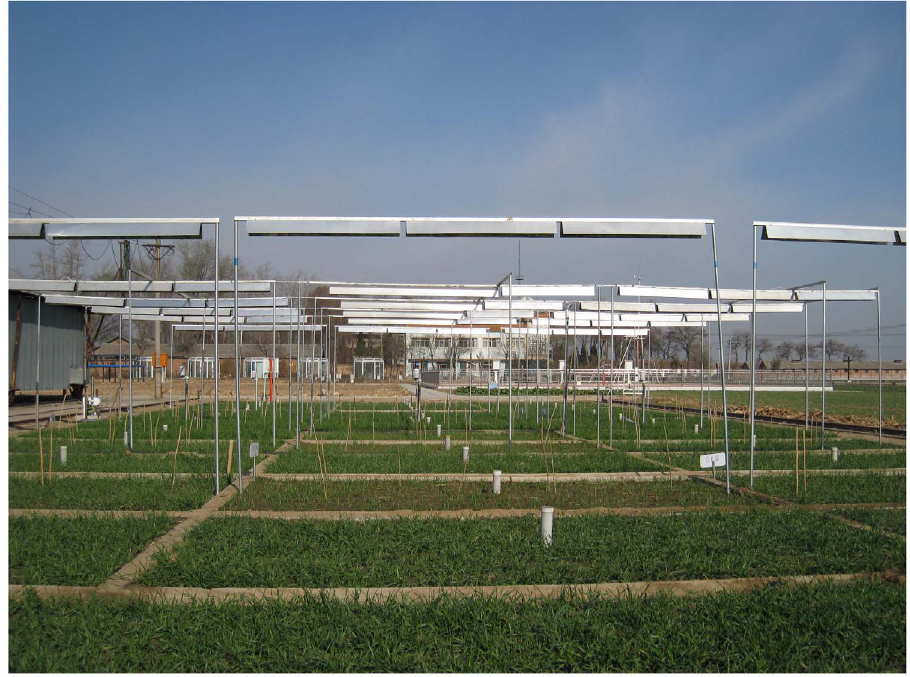
Figure 1. View of heated plots on 10 March 2010 at Hebei province, China.